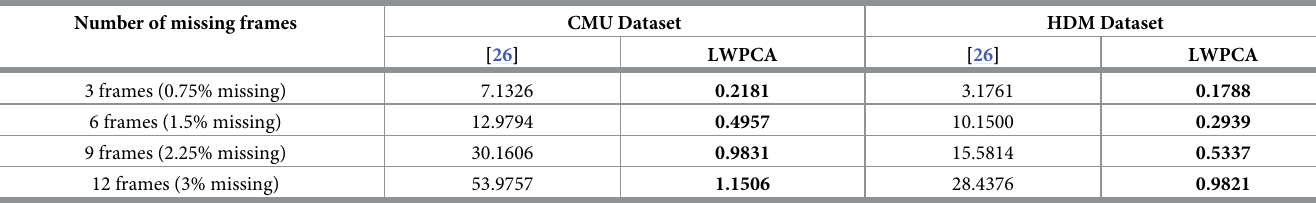
Table 4. Mean recovery errors for missing whole